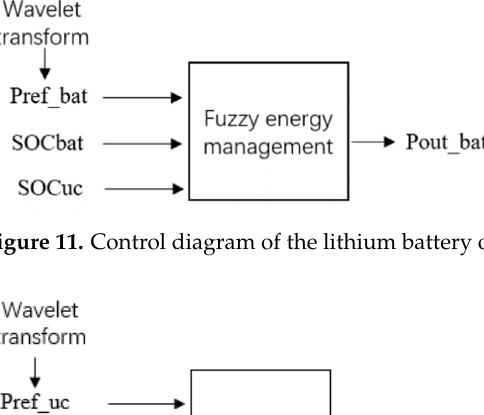
Table 4. Fuzzy rules under driving conditions.